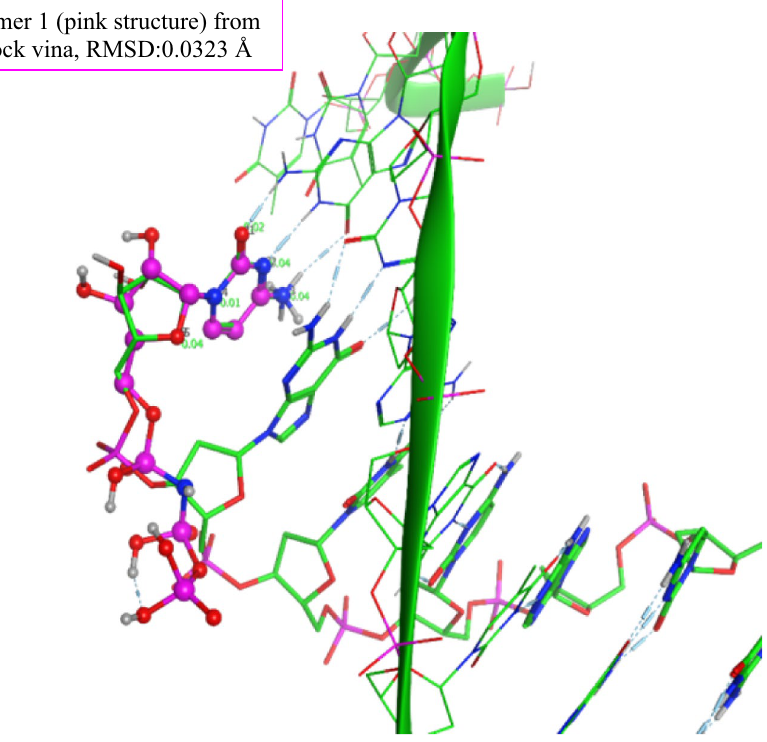
Figure 4. The structural information (obtained by Auto Dock Vina) for the first conformer of CNP (brown) complexed with DNA and DNA polymerase η (Polη) with the least RMSD = 0.0323 Å (structure of Polη not shown